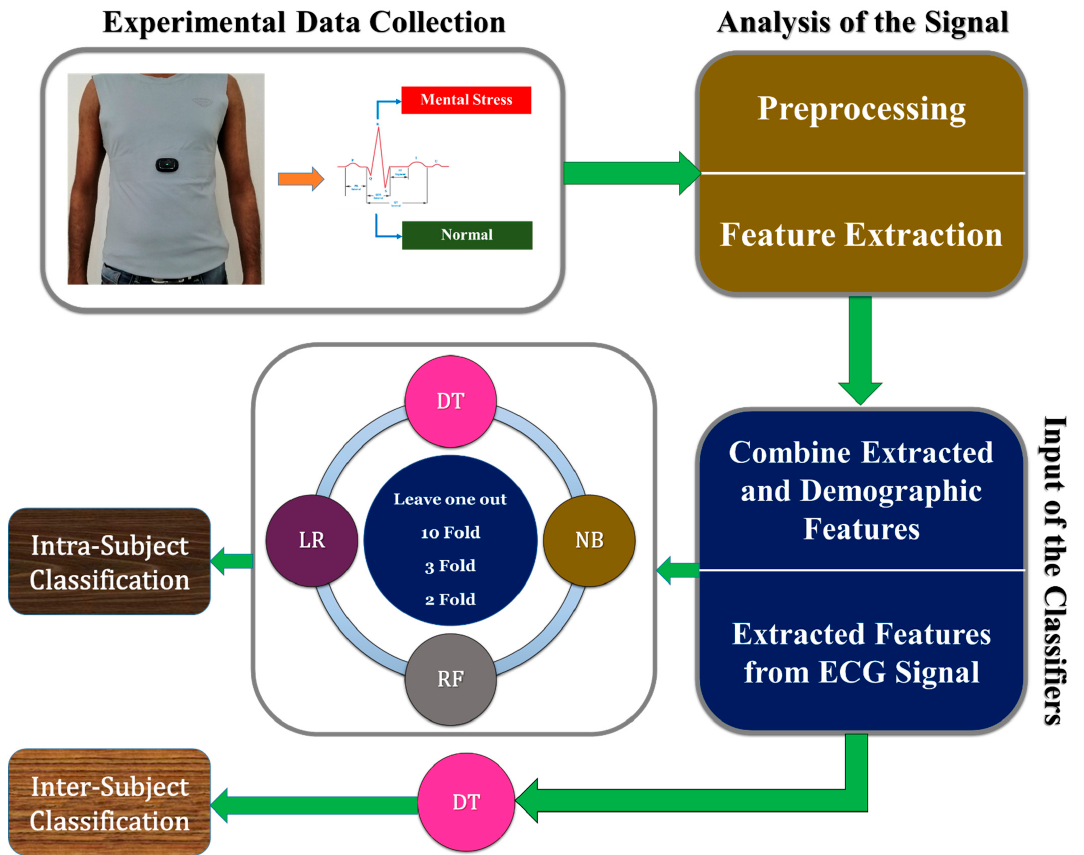
Figure 3. Block diagram of the proposed study.